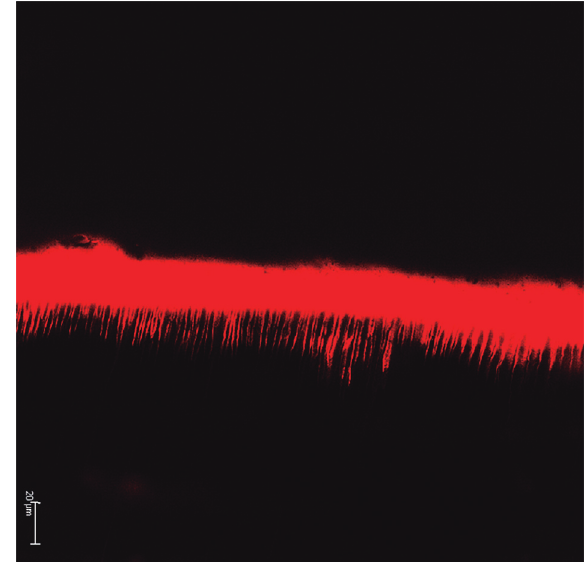
Figure 7a- Interface aspect of bonding system to enamel surface eroded by Zero Coke (ZC). Tags present homogeneous pattern